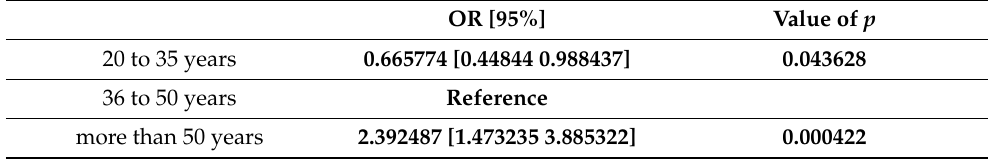
Table 11. Odds ratios of somatic symptoms of fear and age